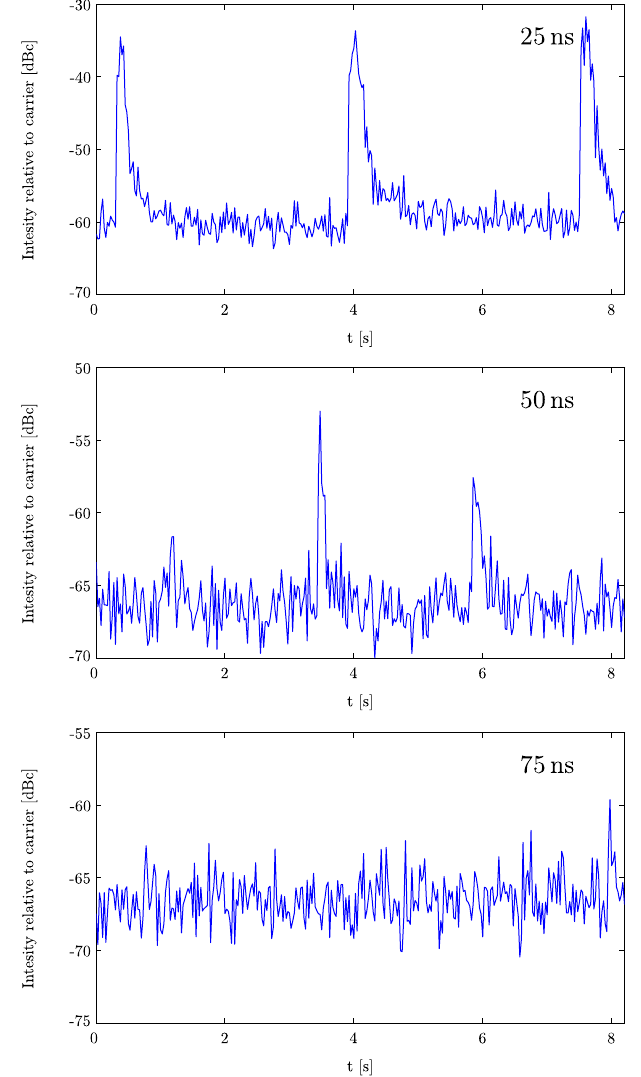
FIG. 11. Comparison of phase modulation signals, measured for the coated SPS vacuum chamber, using the nominal LHC beams with 25, 50, and 75 ns bunch spacing. No signal is seen for any bunch spacing. For the 75 ns beam not even an injection signal is visible. The data were taken with beams of four batches at SPS flat bottom.